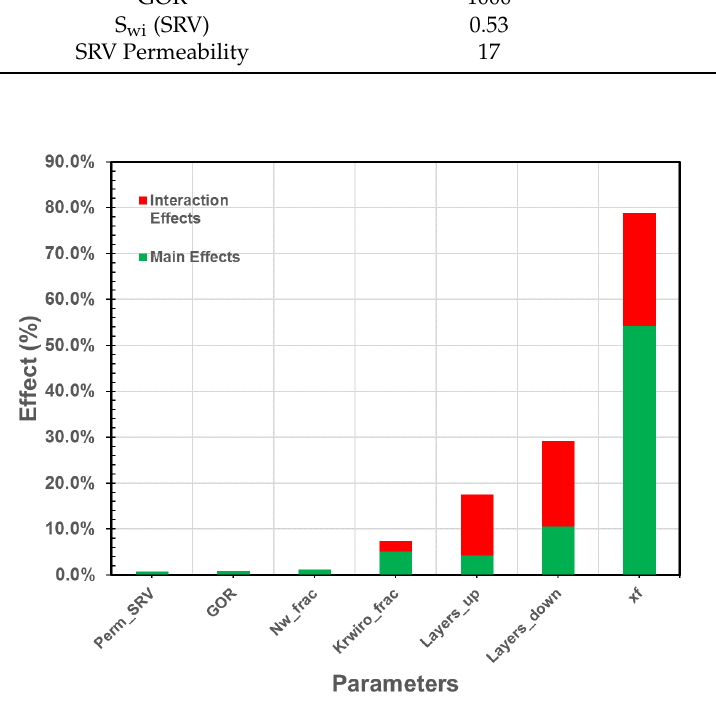
Figure 10. Results of the global sensitivity analysis. Fracture half-length is the dominant (1st ranked) parameter, while the number of layers above and below the well are 2nd and 3rd, respectively, in the ranking.